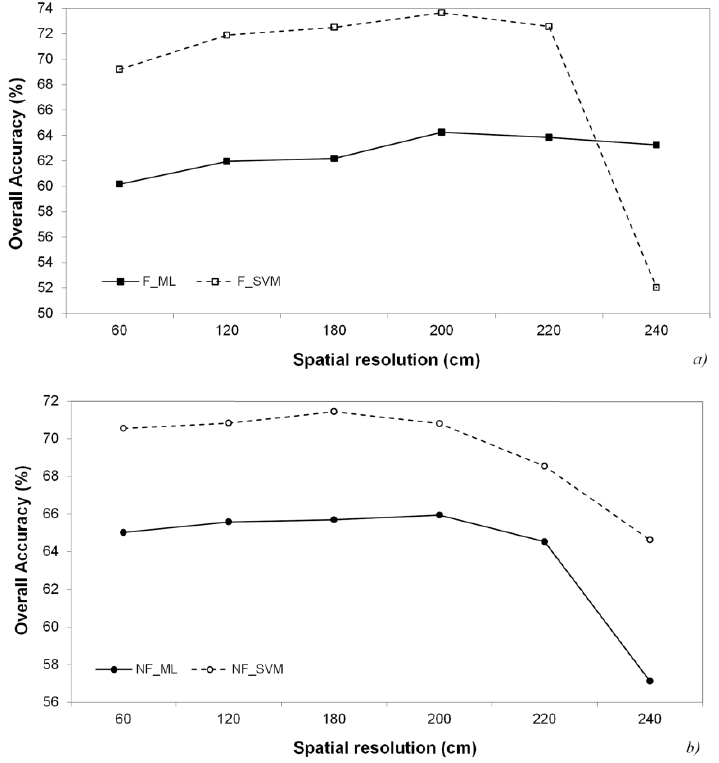
Figure 6. Overall accuracy analysis for the QuickBird 2009 image applying ML and SVM